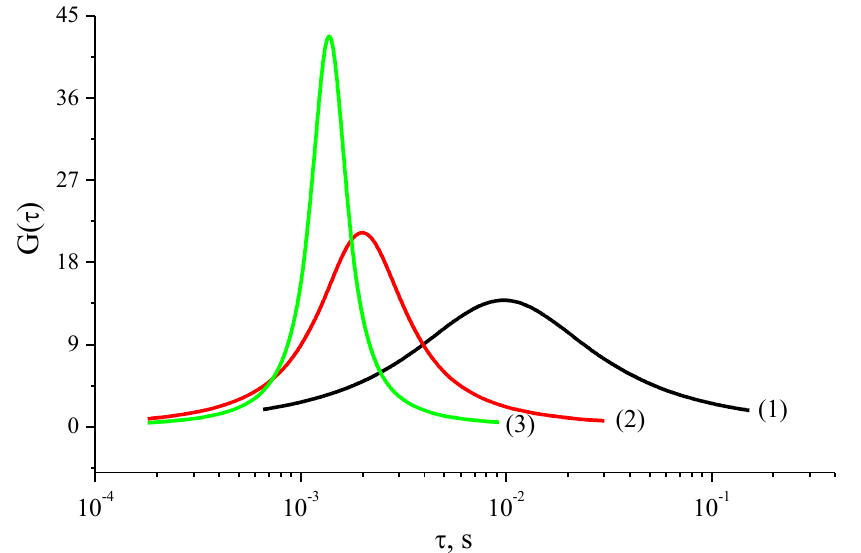
Figure 6. Form of the relaxation time distribution function for por-Si layers at different temperatures T = 223 K (curve (1)), 273 K (curve (2)), 293 K (curve (3)).